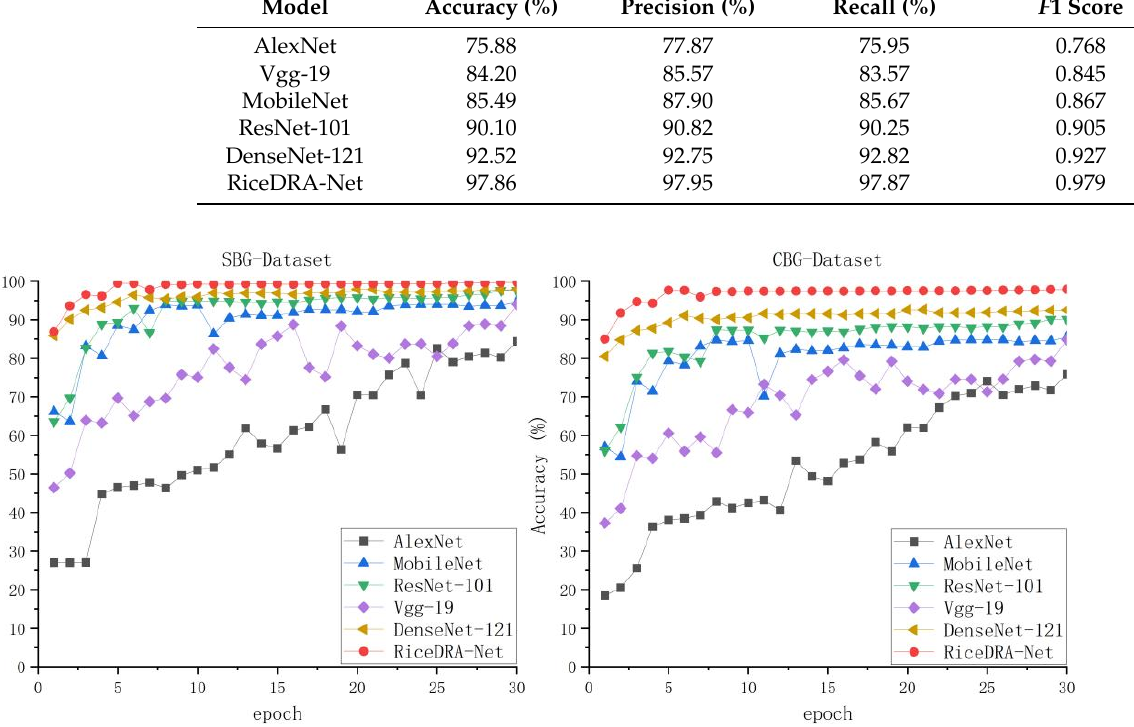
Figure 10. Comparison of the total loss values of the five different models on the test set in a single context. We compared the recognition accuracy of the six models for two different test da- tasets for rice leaf diseases, as shown in Figure 11. It can be observed that the recognition accuracy of RiceDRA-Net was 99.71% for the SBG-Dataset and 97.86% for the CBG-Da- taset. In addition, the rice leaf disease recognition accuracy of RiceDRA-Net with a single background decreased by only 1.85% compared with a complex background. The accu- racy of AlexNet decreased by 8.49%, MobileNet decreased by 9.16%, Vgg-19 decreased by 9.16%, ResNet-101 decreased by 7.53%, and DenseNet-121 decreased by 5.34%. The